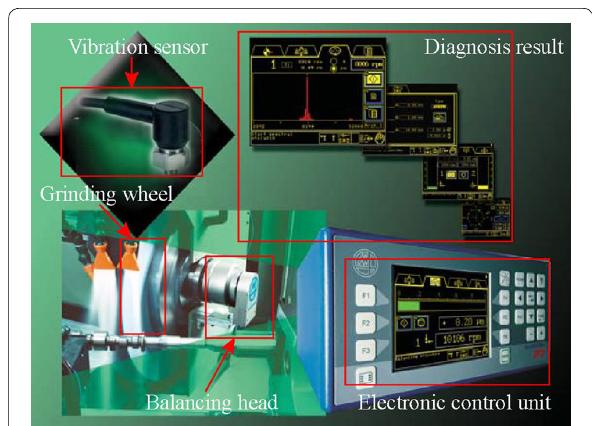
Figure 7 Diagram of automatic balancing system for grinding wheel